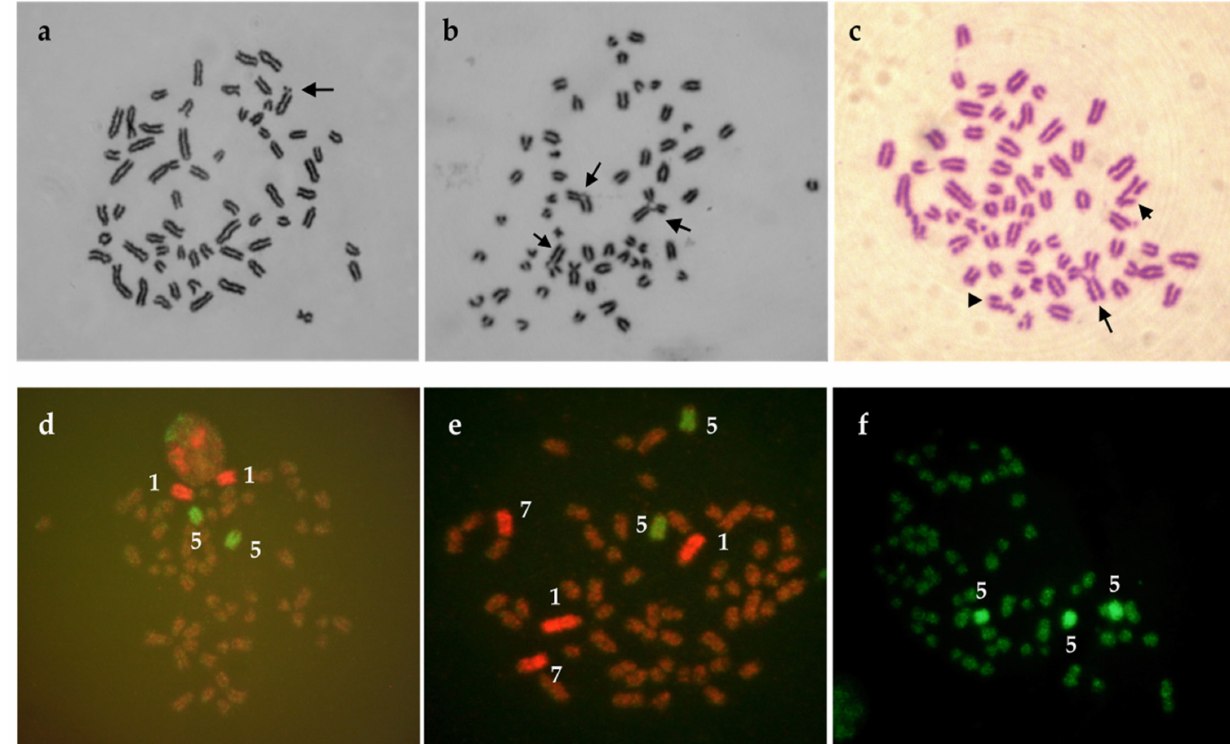
Figure 4. Bull metaphases exposed to pesticides in vitro. ( a ) Isochromatid break after exposure to tebuconazole/pro thioconazole-based fungicide formulation indicated by an arrow ( b ) Chromatid exchanges after exposure to tebuconazole- based fungicide marked with three separate arrows ( c ) Chromatid exchange (the longest arrow), breaks (shorter arrow and arrowhead), and fragmentation (many breaks in the metaphase) after tebuconazole-based fungicide exposure. ( d ) Normal metaphase hybridised with WCP probes BTA 1 and BTA 5. ( e ) Normal metaphase hybridised with WCP probes BTA 1, BTA 5, and BTA 7. ( f ) Aneuploidy. Three copies of chromosome 5 (BTA 5) are visible in the metaphase plate. Metaphase originates from cultures treated with tebuconazole-based fungicide